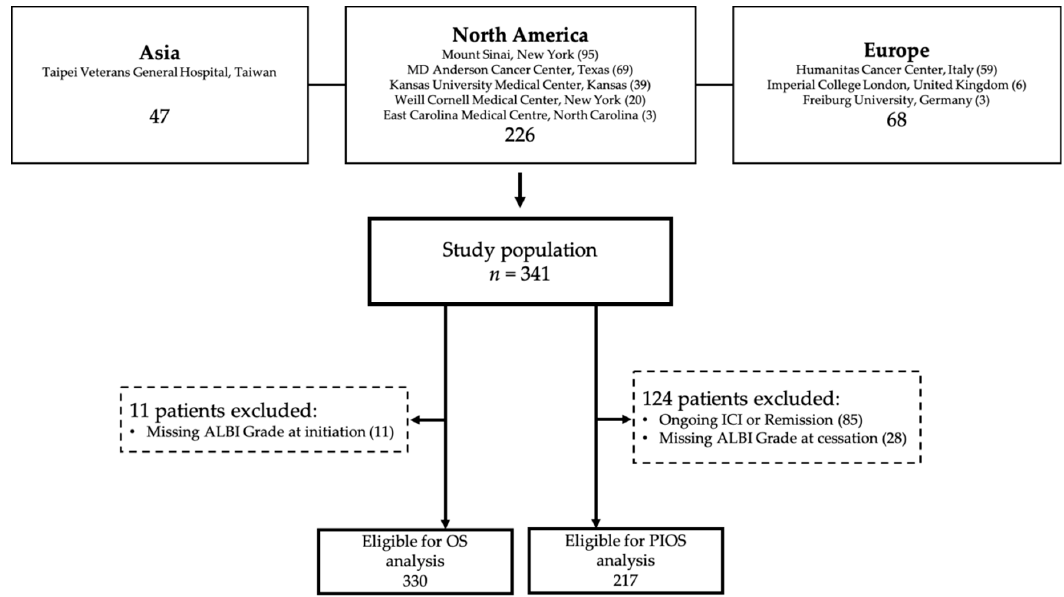
Figure 1. Study flow chart.